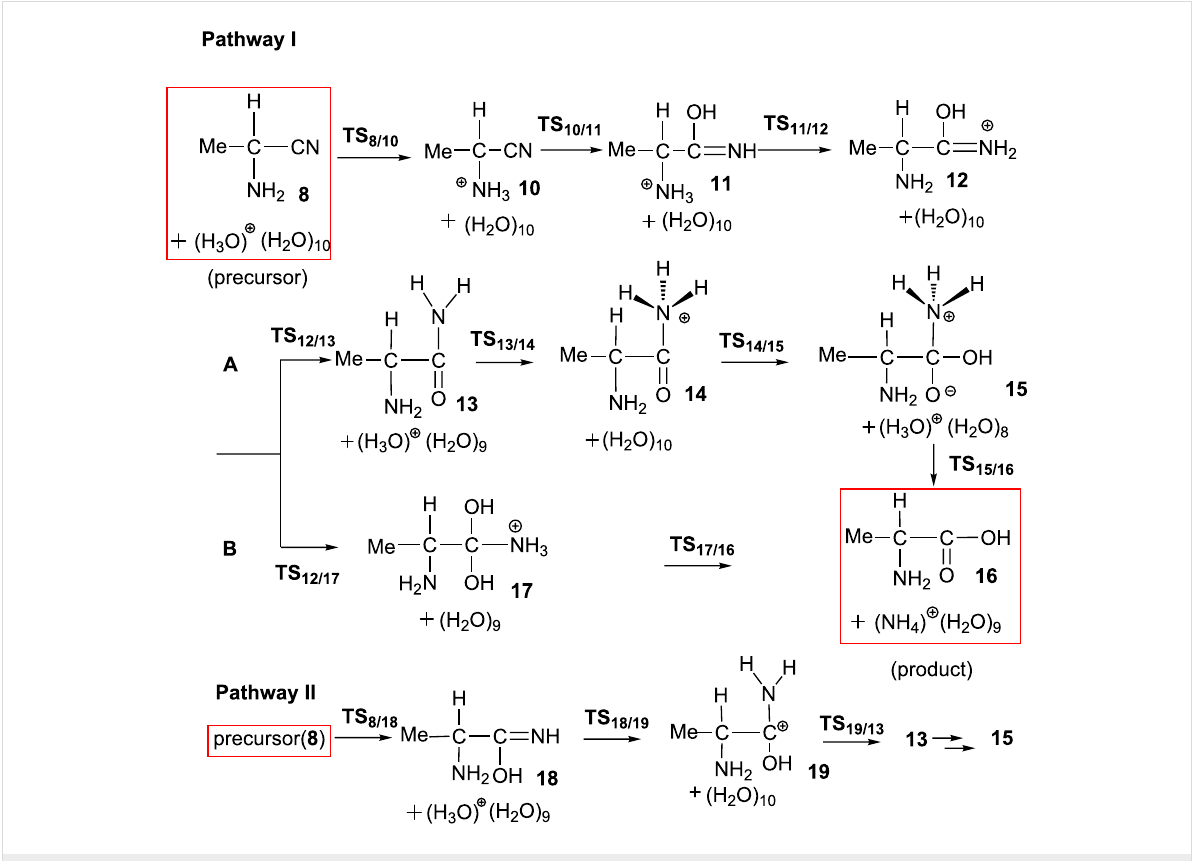
Scheme 8: Elementary processes of the acid-catalyzed hydrolysis of 2-amino-propanonitrile.